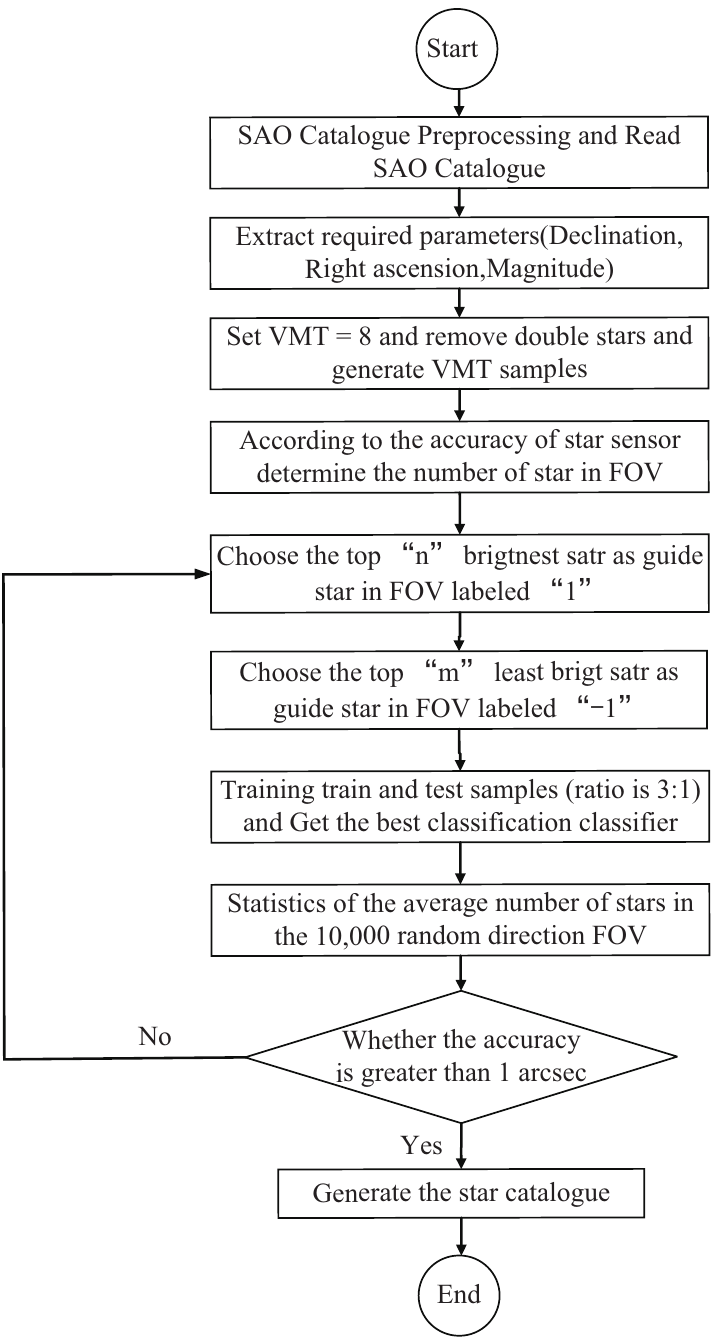
Figure 7. Flowchart of the algorithm used to generate star catalogues. We obtained the training and test samples using the MFM star catalogue. Training samples were used to train the corresponding classifier. The classifier was then used